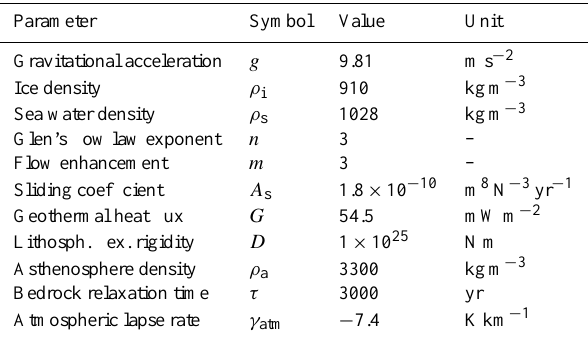
Table 2. Ice sheet model parameter values.